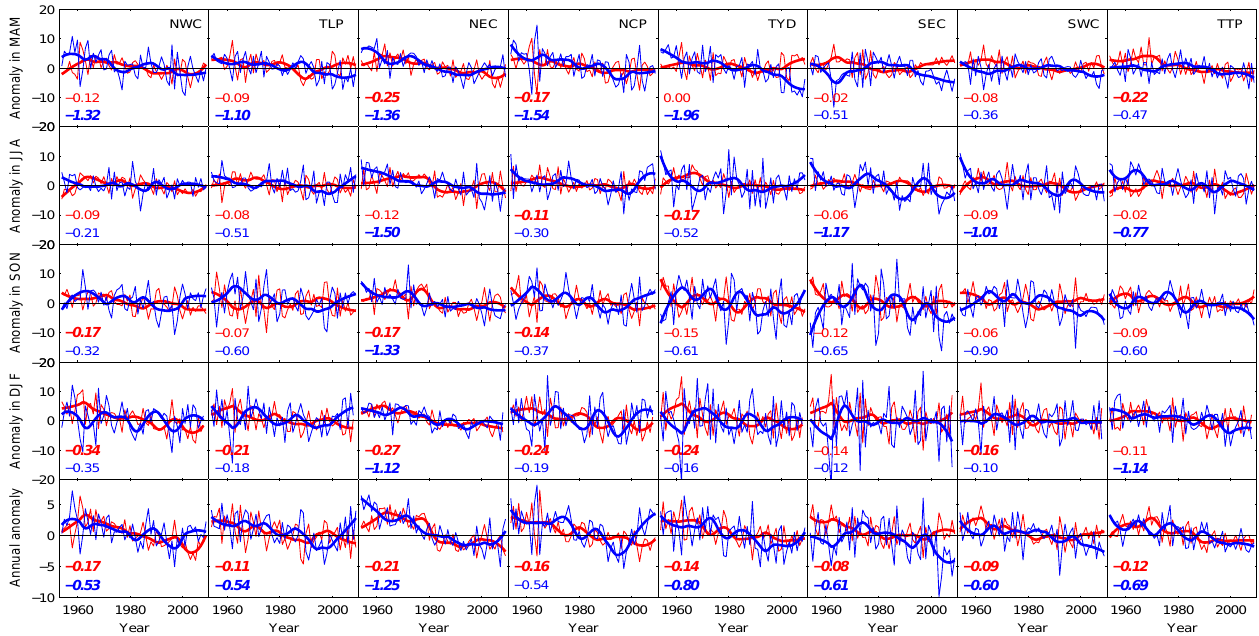
Fig. 2. Time series plots of average regional anomalies of diurnal temperature range (red) and total cloud cover (blue), plotted together with the smoothed series using robust locally weighted regression algorithm “Lowess”. The long-term trends of diurnal temperature range and cloud cover are also included in the figure and the bold/italic values represents that the trends are significant at the 99%